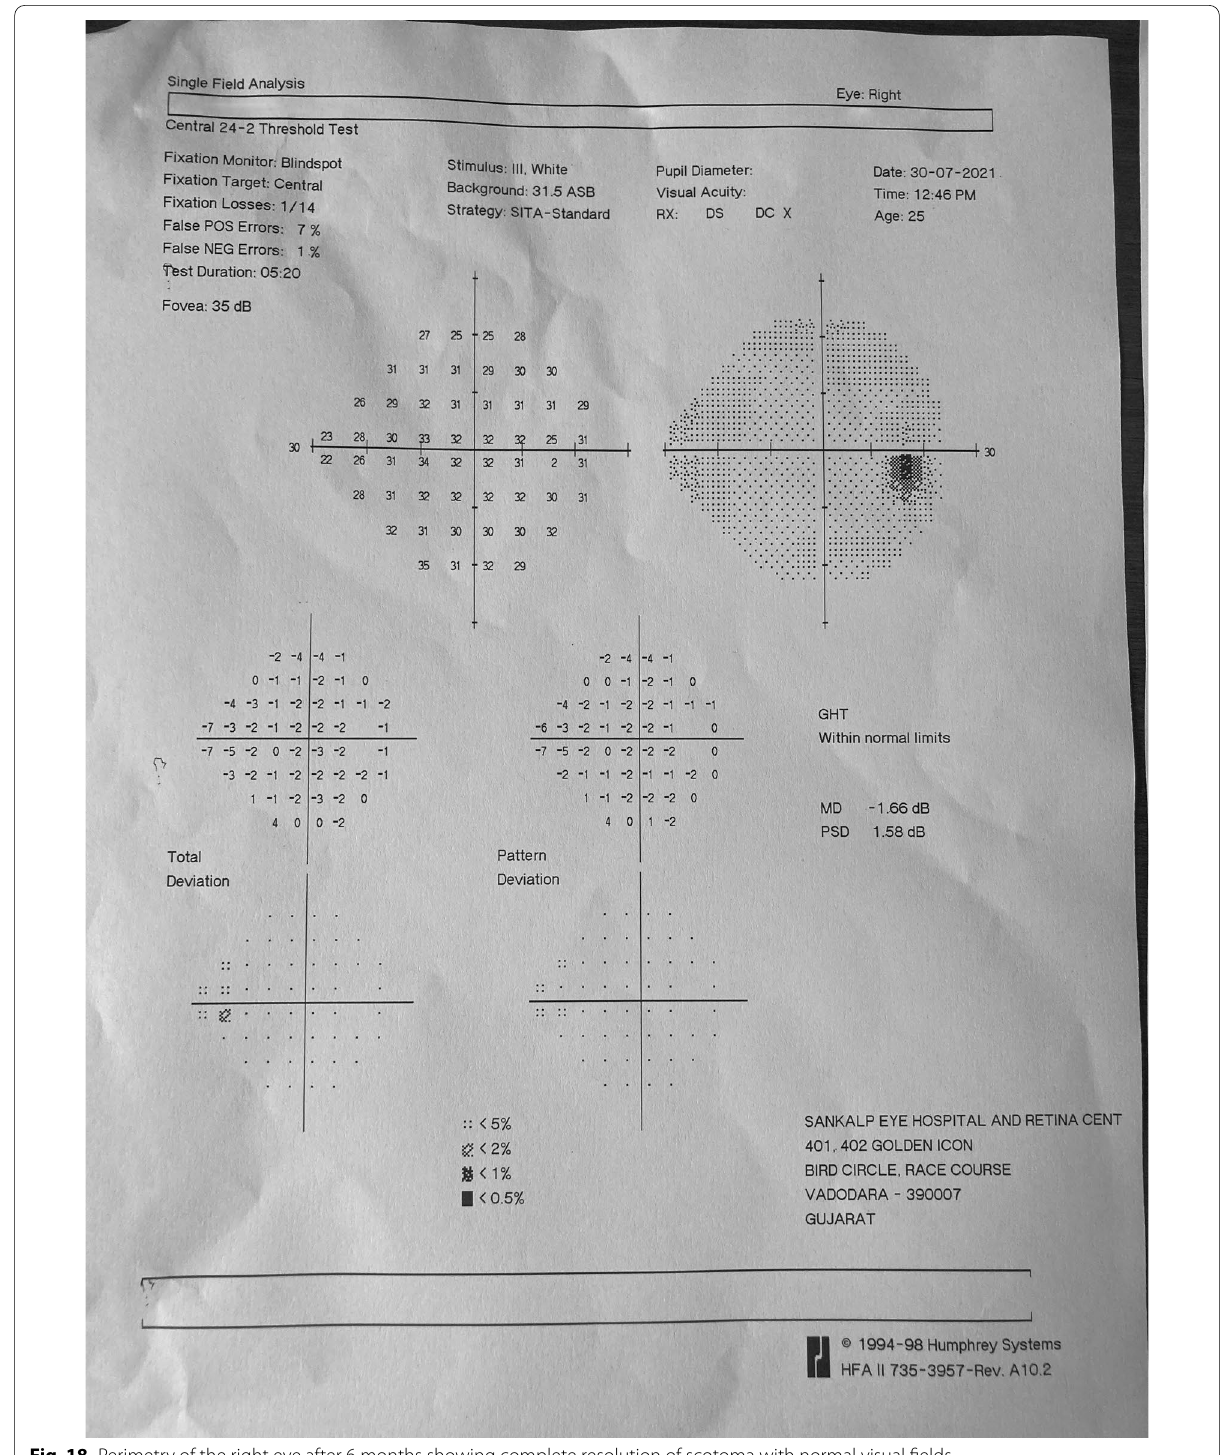
Fig. 18 Perimetry of the right eye after 6 months showing complete resolution of scotoma with normal visual